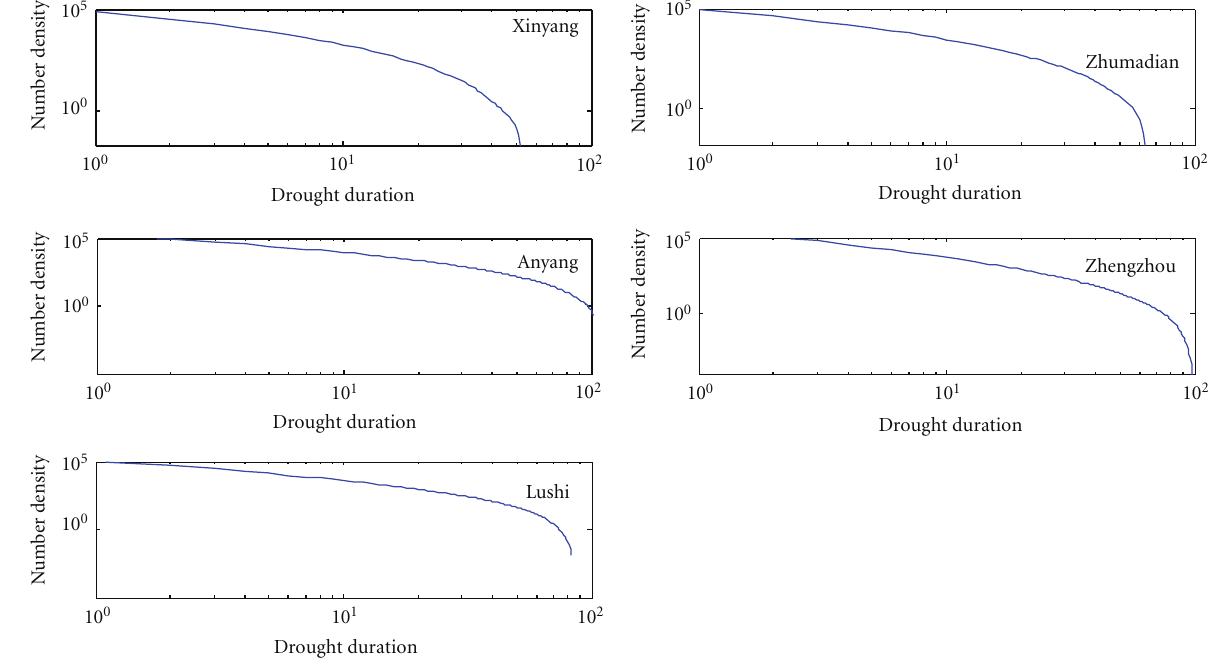
Figure 4: Log-log plot of the probability number density for drought duration.